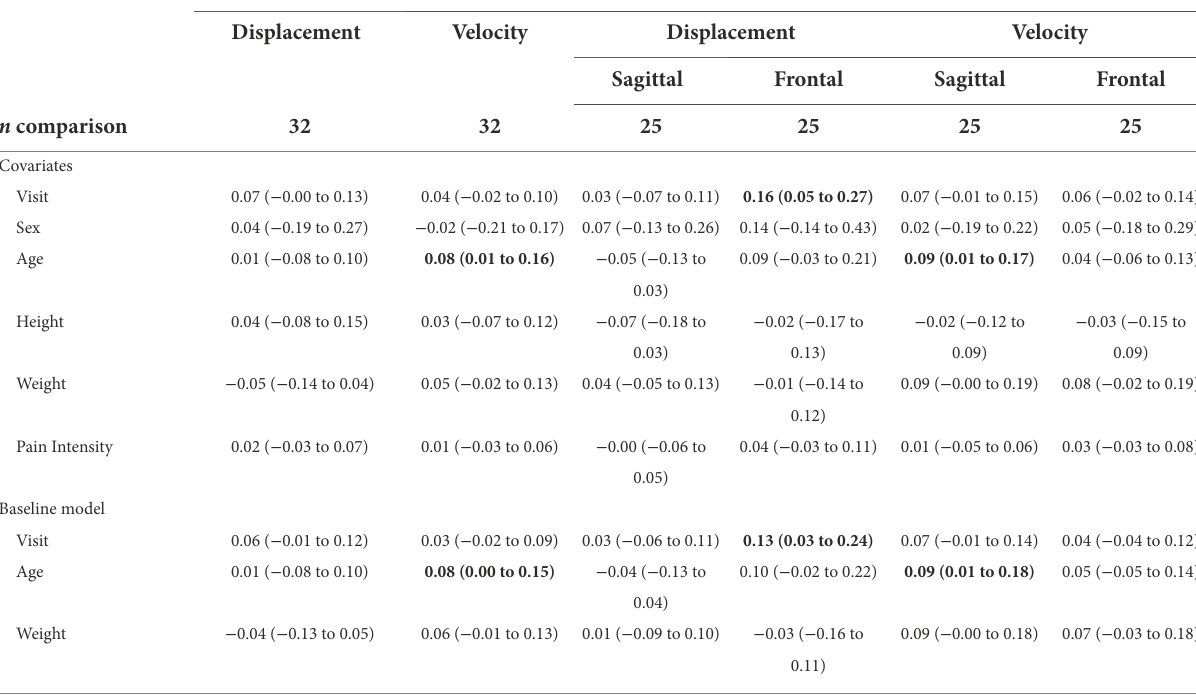
TABLE 3 Models assessing the contribution of covariates and baseline models only including the covariates selected as relevant.